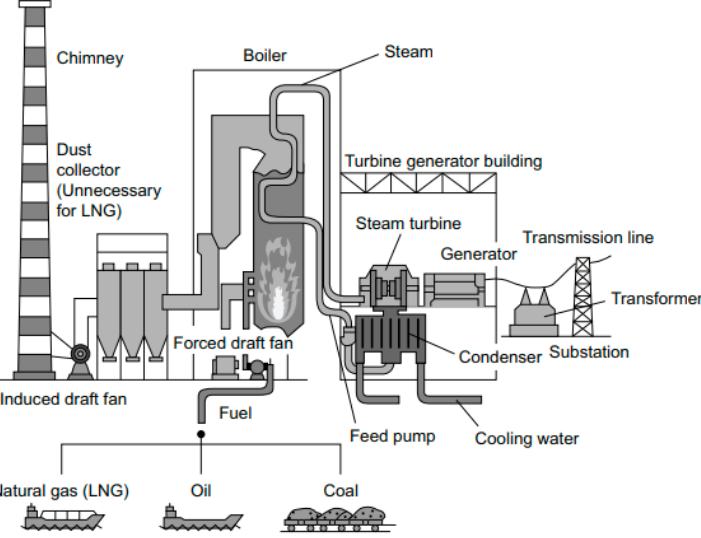
Membranes 2021 , 11 , x FOR PEER REVIEW Figure 2. The seven power stations in Kuwait and their output power. Figure 1. The seven power stations in Kuwait and their output power.